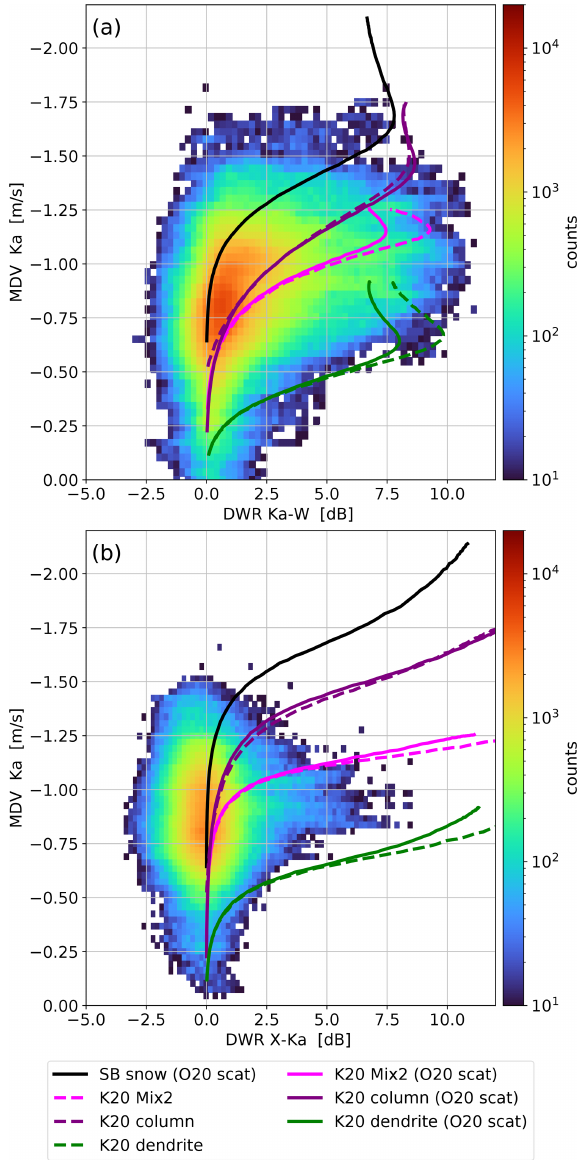
Figure 5. Comparison of the modeled and observed relationship between MDV and DWR: (a) DWR Ka,W , (b) DWR X,Ka . The his- togram shows the observations from the Tripex campaign (D18). The lines show the theoretical MDV at a given DWR for the v t size relations of snow particles as assumed in the SB default (black) and as modeled in K20. For the dashed lines, the SSRGA param- eters have been directly derived from the corresponding aggregate ensemble properties (as found in Ori et al., 2021). The solid lines use SSRGA parameters as used in O20 in order to illustrate the un- certainty due to the scattering parameters. The lines are calculated using PAMTRA and the properties of the US standard winter atmo- sphere at